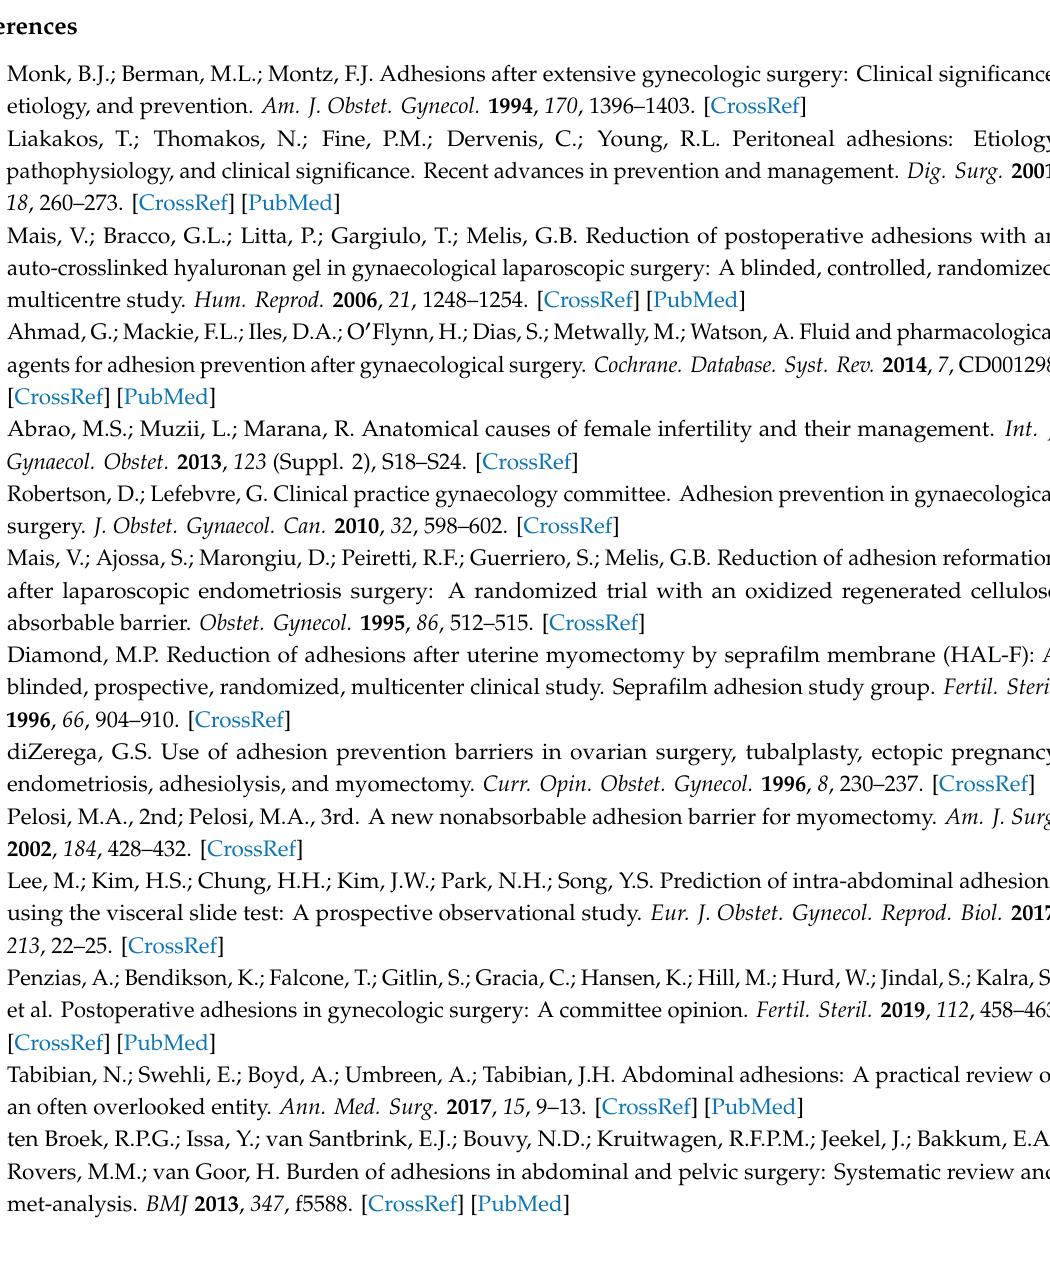
Figure S1: Summary of the planned procedures in this clinical trial, Table S1: Overall satisfaction for patients and surgeons at 4 weeks after surgery, Table S2: Surgeon satisfaction with handling anti-adhesion agents on the day of surgery, Table S3: Comparisons of adverse events among the three groups in the safety